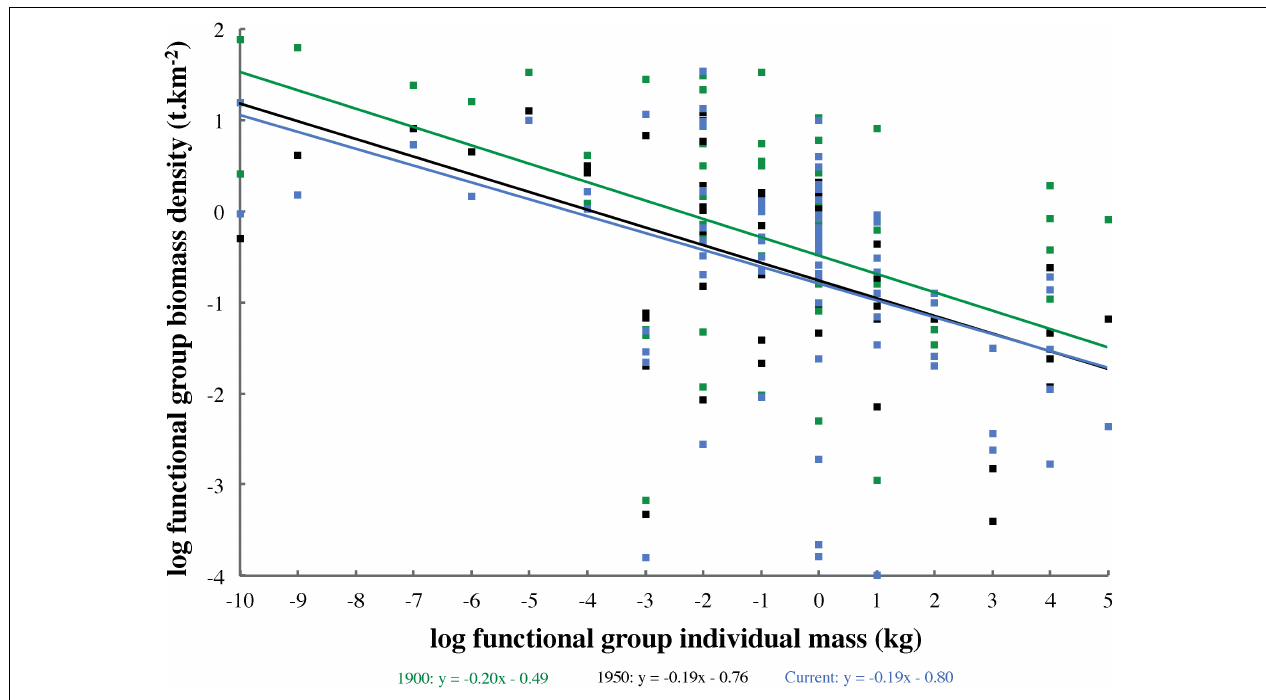
FIGURE 3 | Biomass size spectra for Ecopath models representing three ecosystem states (1900, 1950, and current). Functional group biomasses were not normalized by size interval width or grouped into logarithmically binned size classes.